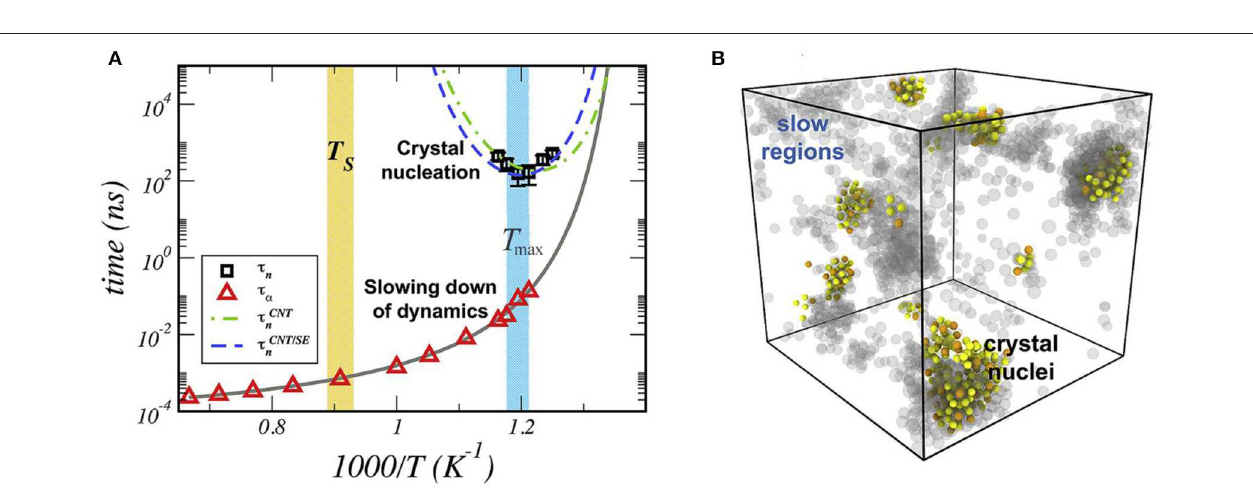
FIGURE 3 | Evolution of the coarse-grained immobility (gray) and crystallinity (blue) fields from a particular trajectory. (A) Pre-nucleation stage, absence of crystalline order in the large immobile domains. (B,C) During nucleation, an ice nucleus forms (B) and grows (C) within the immobile domain. The diameter of the ice-like region in C is ∼ 3.4nm (reprinted from [21] under the Creative Commons CC BY-NC-ND license).